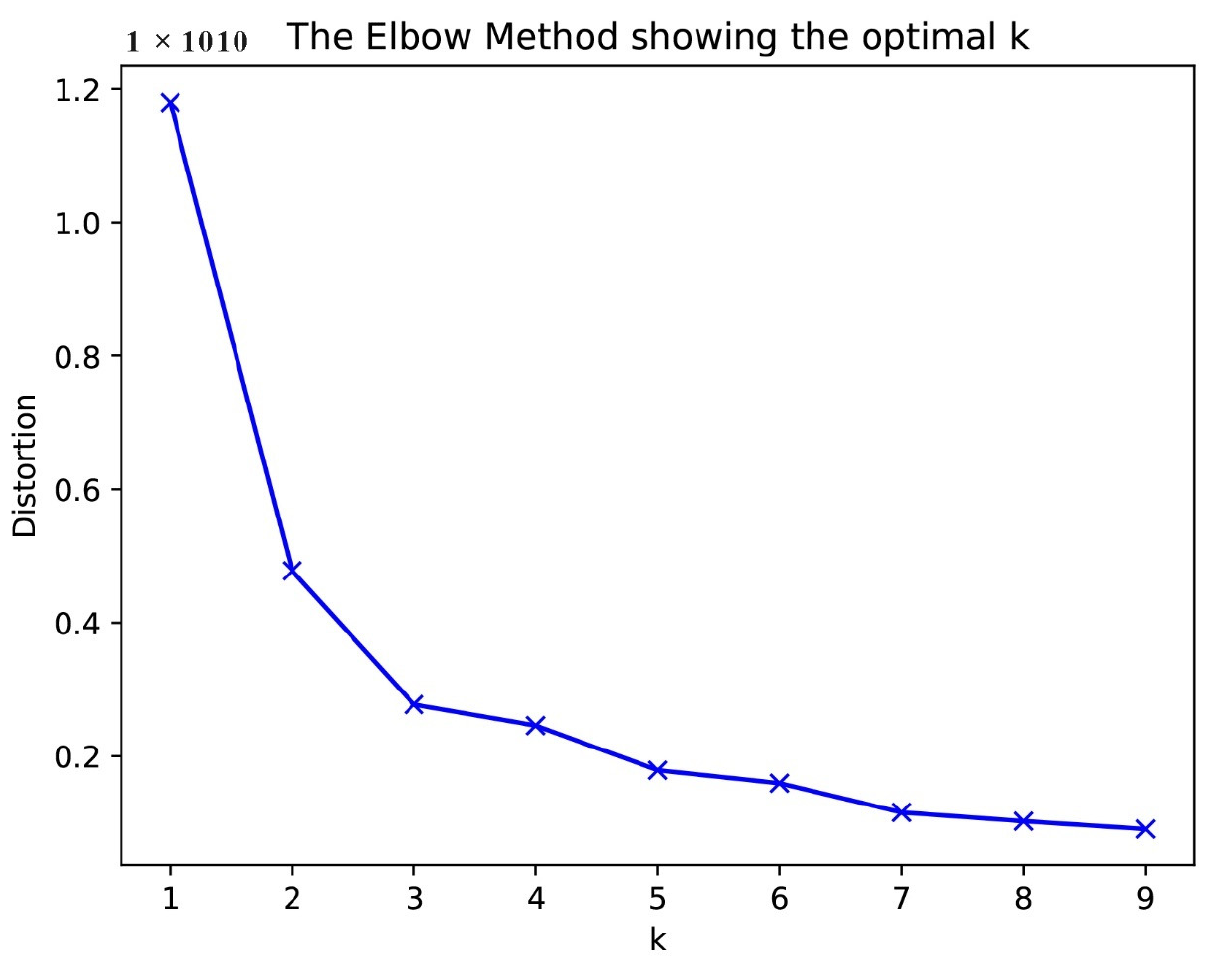
Figure 5. The output of the elbow method, created by authors.